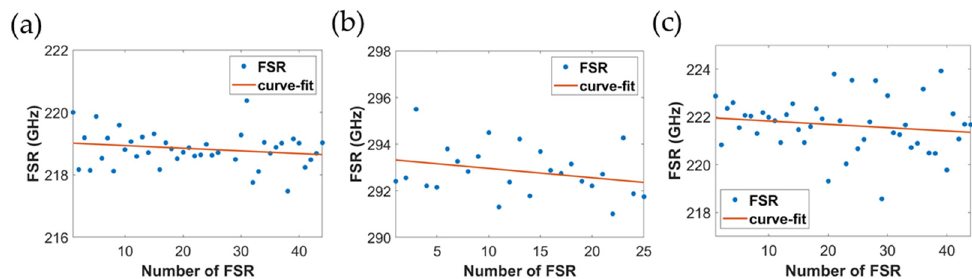
Figure 8. Distribution of FSRs of the fundamental TE mode for ( a ) air-cladded, ( b ) oxide-cladded, and ( c ) polymer-cladded waveguide microresonators.